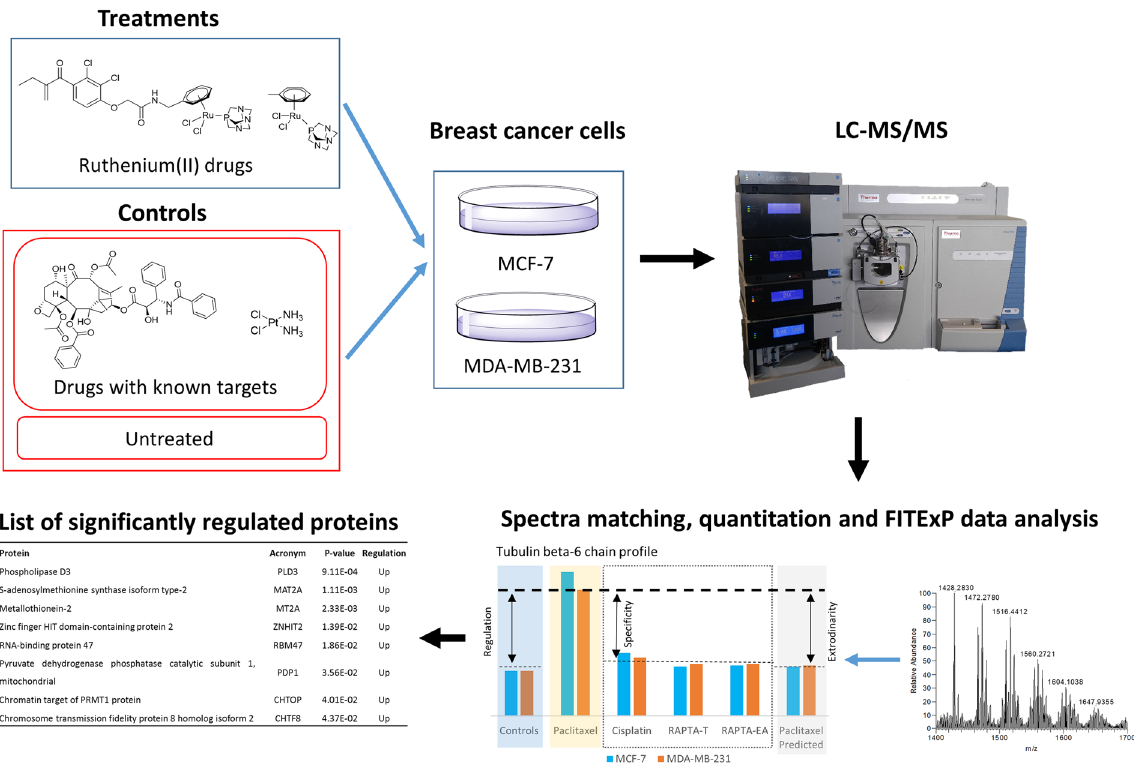
Figure 2. Schematic of the approach used in this study. For more details concerning the FITExP method refer to ref.